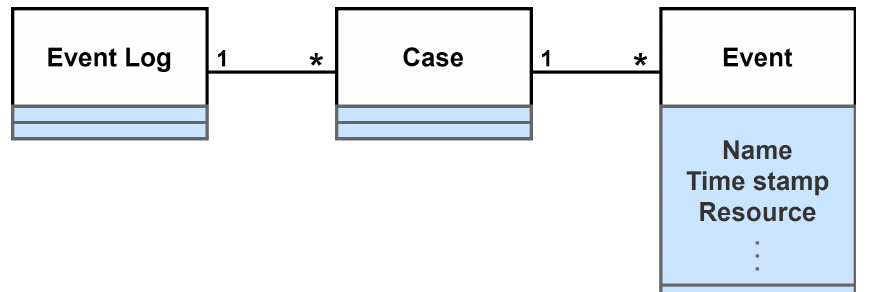
Figure 1. Diagram illustrating inter-dependencies between event